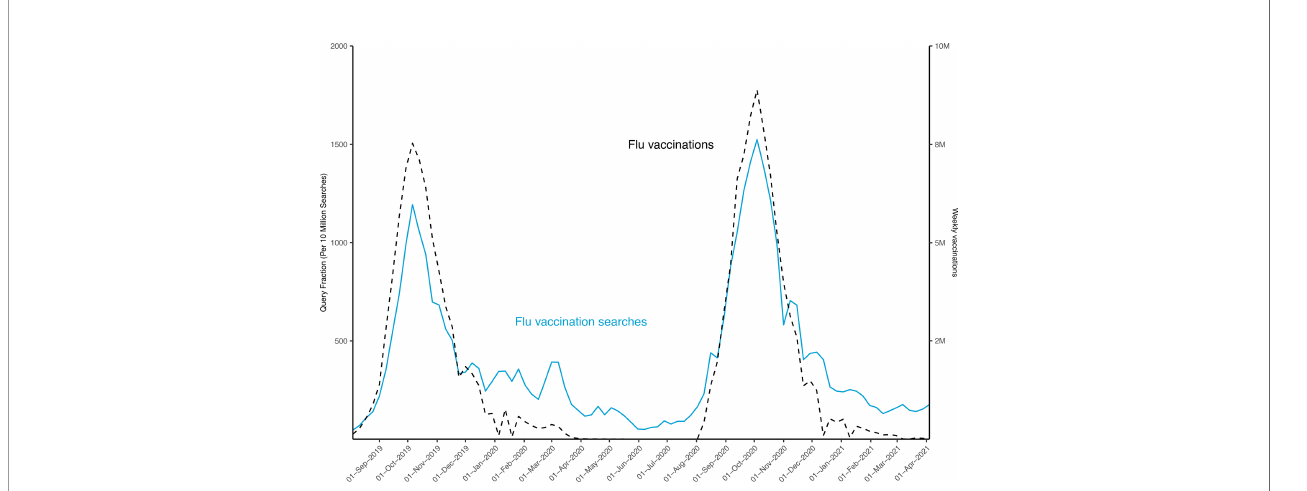
FIGURE 5 | Search Trends for top 3 terms related to in fl uenza vaccination and applied vaccinations in the US. Weekly online searches from August 4, 2019, to April 10, 2021, for the top 3 terms related to “ fl u shot ” . Weekly vaccinations are shown for the 2019-2020 and the 2020-2021 in fl uenza vaccination seasons: from